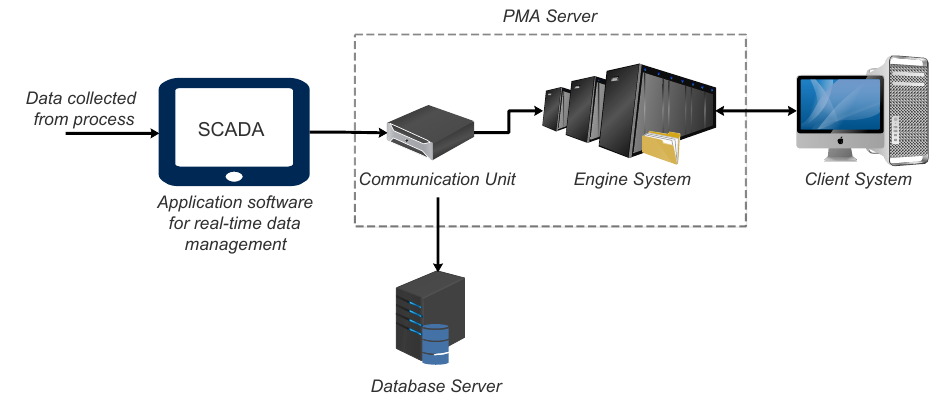
Figure 1. Description diagram of the PMA